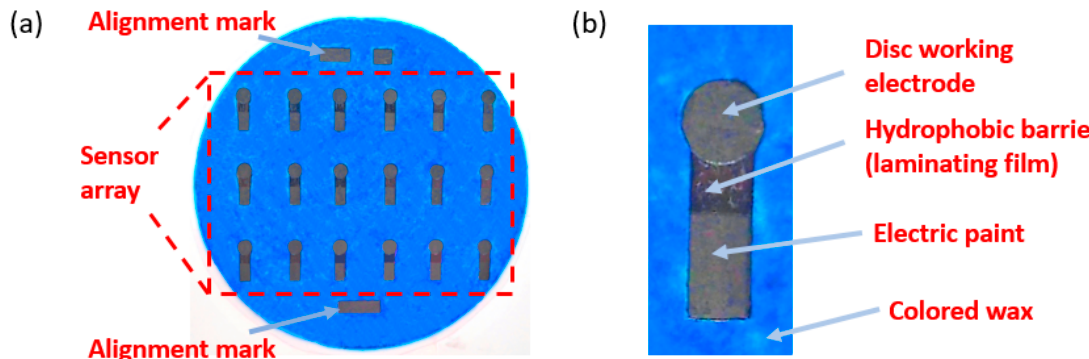
Figure 3. Pictures of a wax-printed electrochemical paper-based sensor: ( a ) Optical image of working electrode array on a 90 mm diameter filter paper; ( b ) disc working electrode (4 mm diameter) which is surrounded by colored wax and a hydrophobic barrier on top [67] .